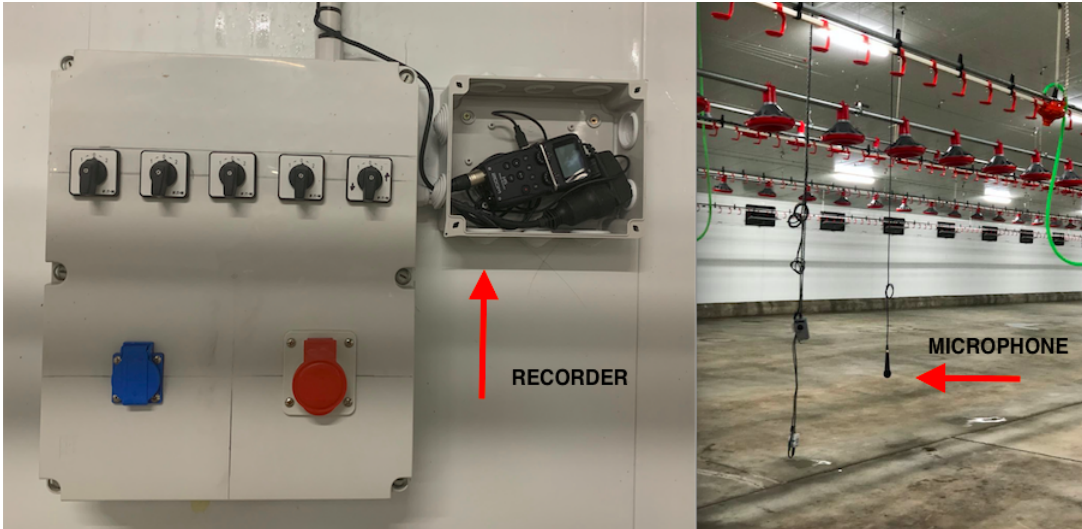
Figure 2. Acoustic equipment deployment in the farm H1. On the left, the recorder location. On the right, the microphone hanging from the ceiling in order to avoid physical interaction with the